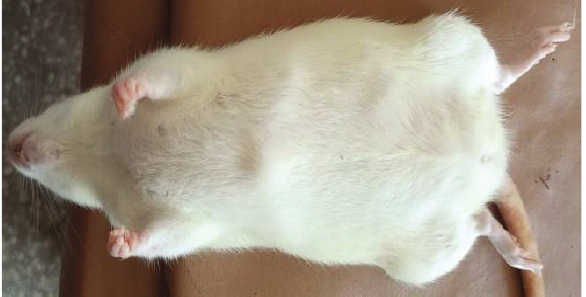
Fig-2: Rat of Group C with improved arthrogram